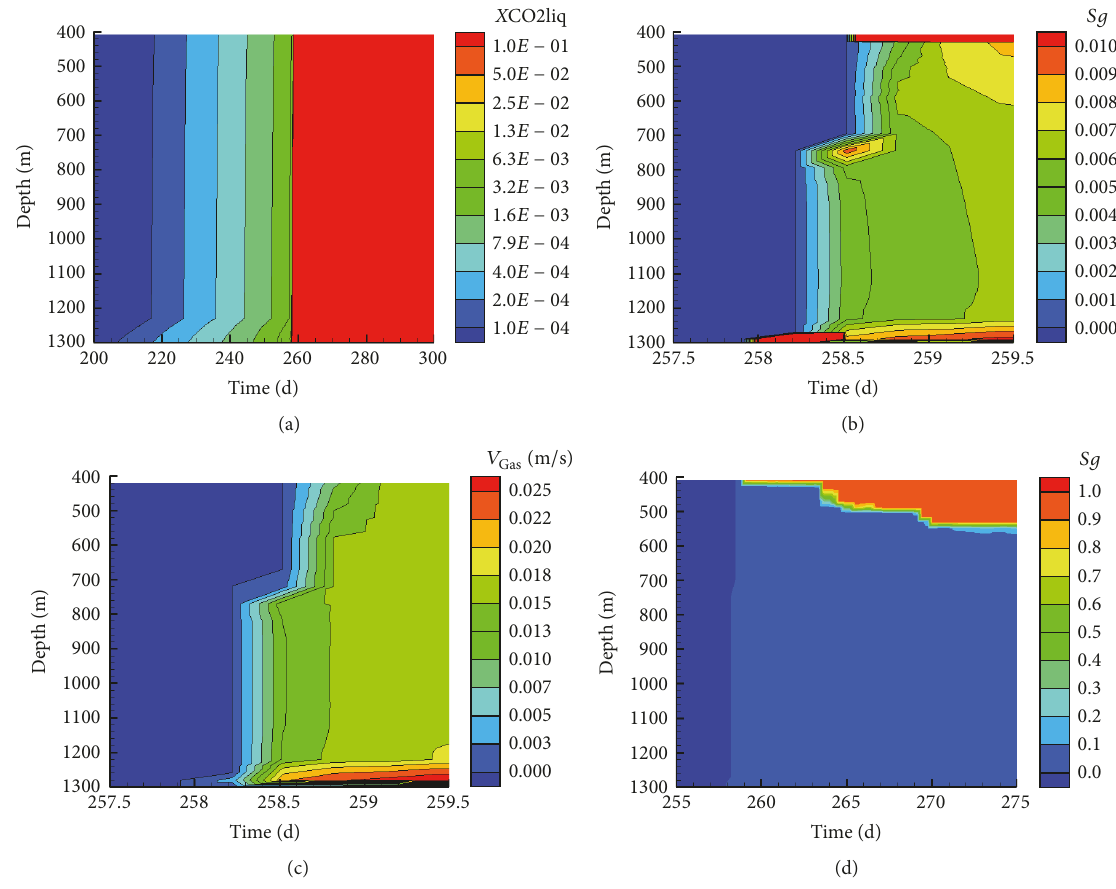
Figure 6: Distributions of the dissolved CO 2 mass fraction 𝑋 CO 2 liq , gas saturation 𝑆𝑔 , and gas phase flow rate 𝑉 in Case 1 during the few days around the breakthrough of CO 2 -rich phase at 258th day. Note that the fraction of dissolved CO 2 constantly becomes saturated if gas phase CO 2 evolves, working as a flag to trace the occurrence of two phases in